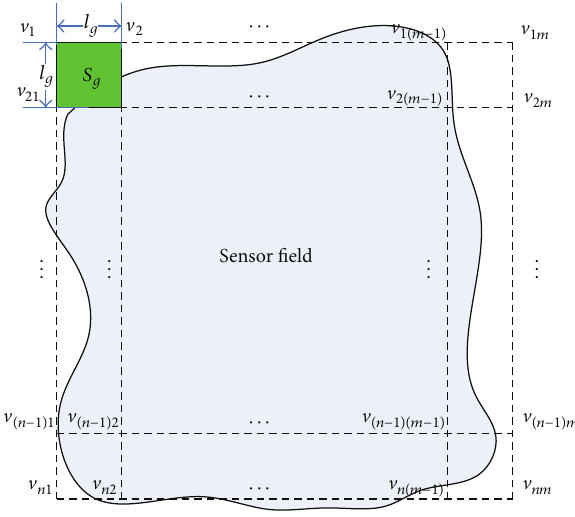
Figure 3: Grid cells of sensor